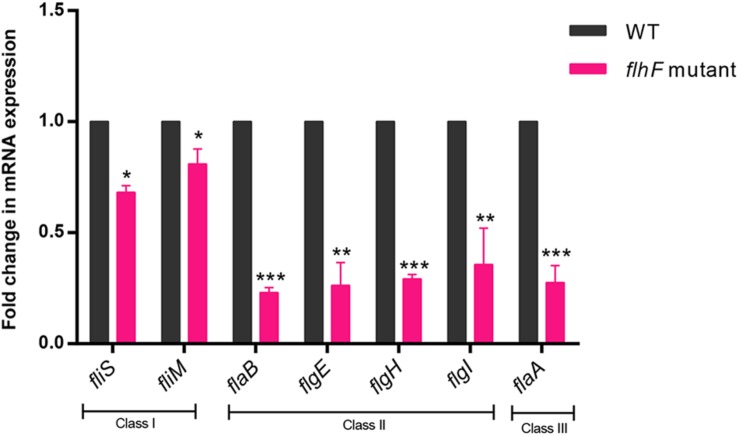
qRT-PCR for verification of RNA-Seq data. qRT-PCR data demonstrated correlation with the RNA-Seq data when investigating the transcript fold-change difference between WT strain and the flhF mutant strain. Each sample was examined in three biological replicates and was repeated with three technical replicates. Data are presented as mean ±SD. Data were analyzed by using a one-sample t-test (* P < 0.05, ** P < 0.01, *** P < 0.001).